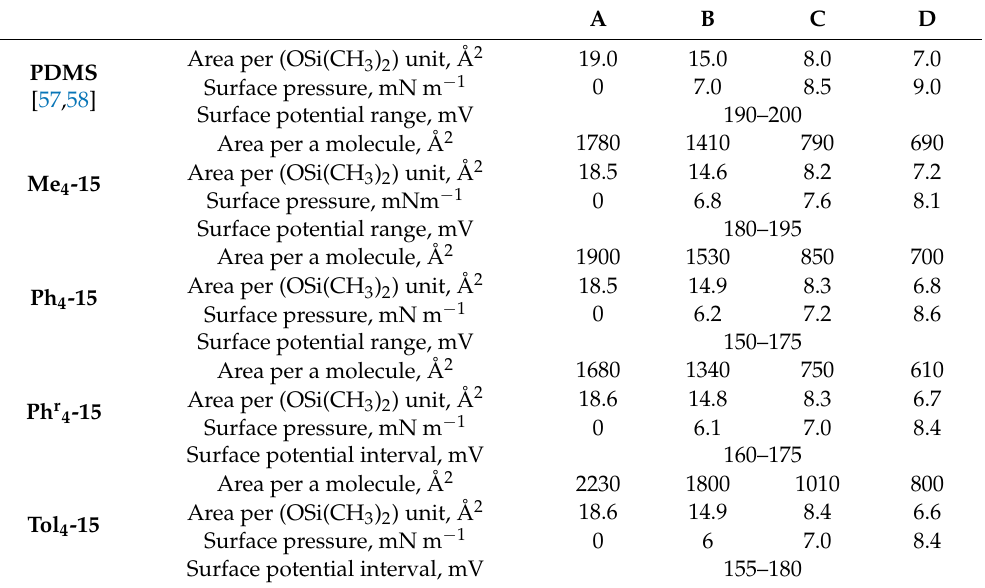
Figure 11. π -A ( 1 – 4 ) and ∆ U-A ( 5 – 7 ) compression ( 1 , 3 – 7 ) and expansion isotherms ( 2 ) of Ph r 4 -15 ( 1 , 2 , 5 ), Ph 4 -15 ( 3 , 6 ), and Tol 4 -15 ( 4 , 7 ) Langmuir layers. T = 20 °C. Table 4. Characteristic points A–D of π -A and ∆ U-A isotherms for Me 4 -15 , Ph 4 -15 , Ph r 4 -15 , Tol 4 -15